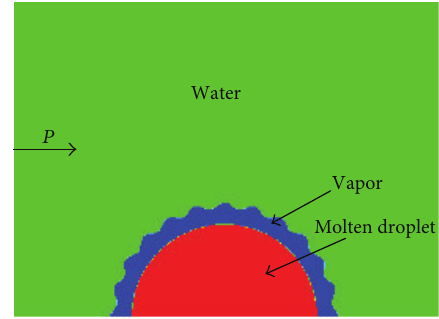
Figure3:Configurationofthethermaldropletbehaviorcalculation.